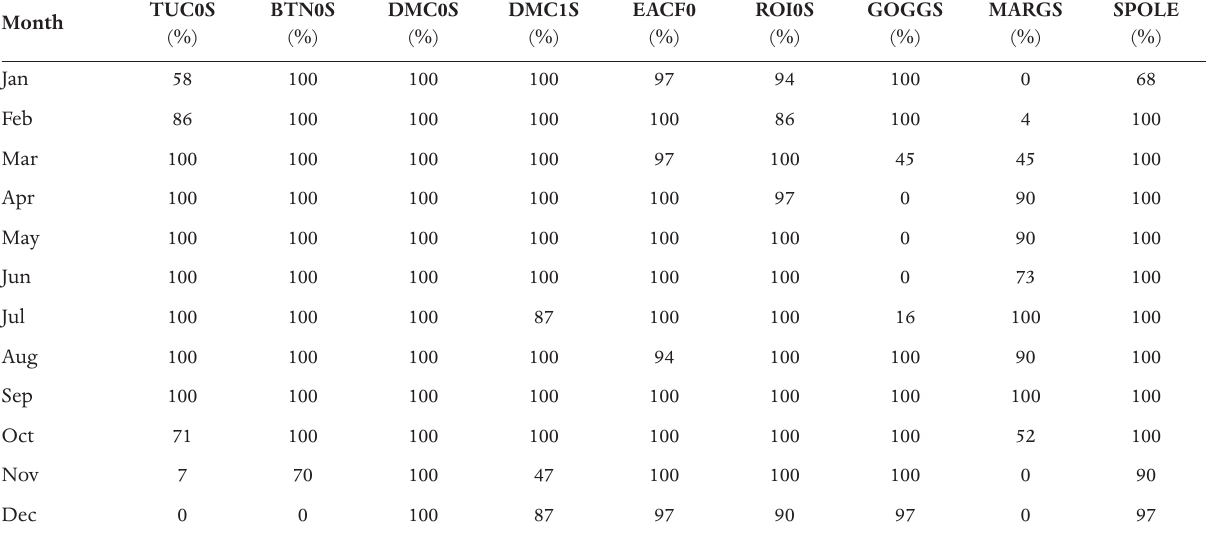
Table 2. Days of available data in each month and for each receiver, expressed as percentages.